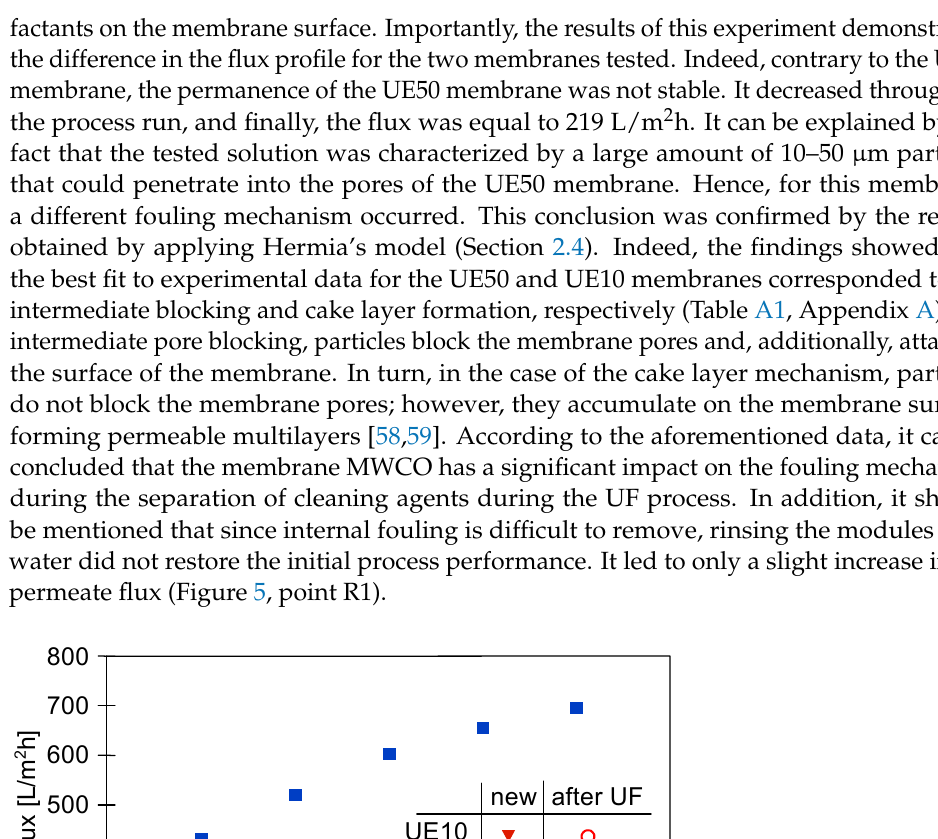
Table 5. Surfactant retention [%] by the PES membranes. Feed concentration: SDS (130 mg/L), Triton X-100 (500 mg/L), waste: white (0.5%)+wax (0.2%).